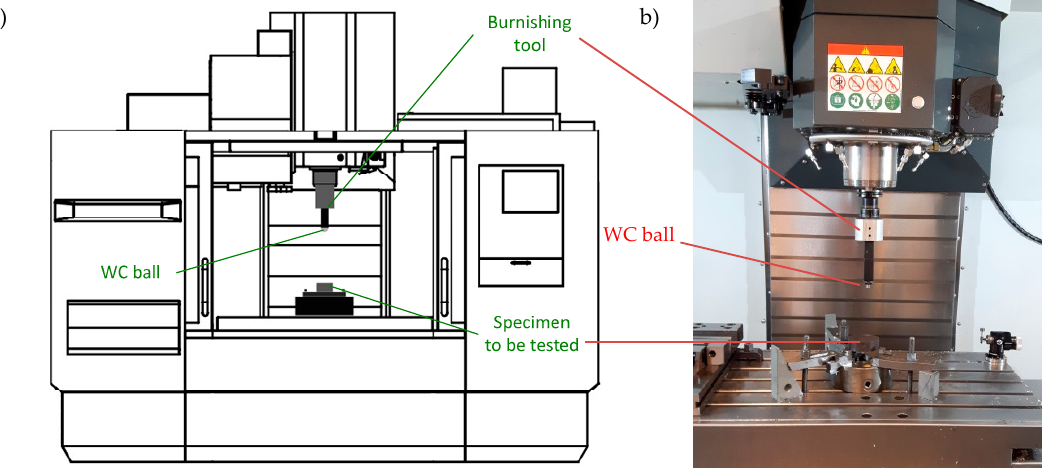
Figure 1. Scheme of the Computer Numerical Control (CNC) test stand ( a ) and photo of working chamber ( b ).